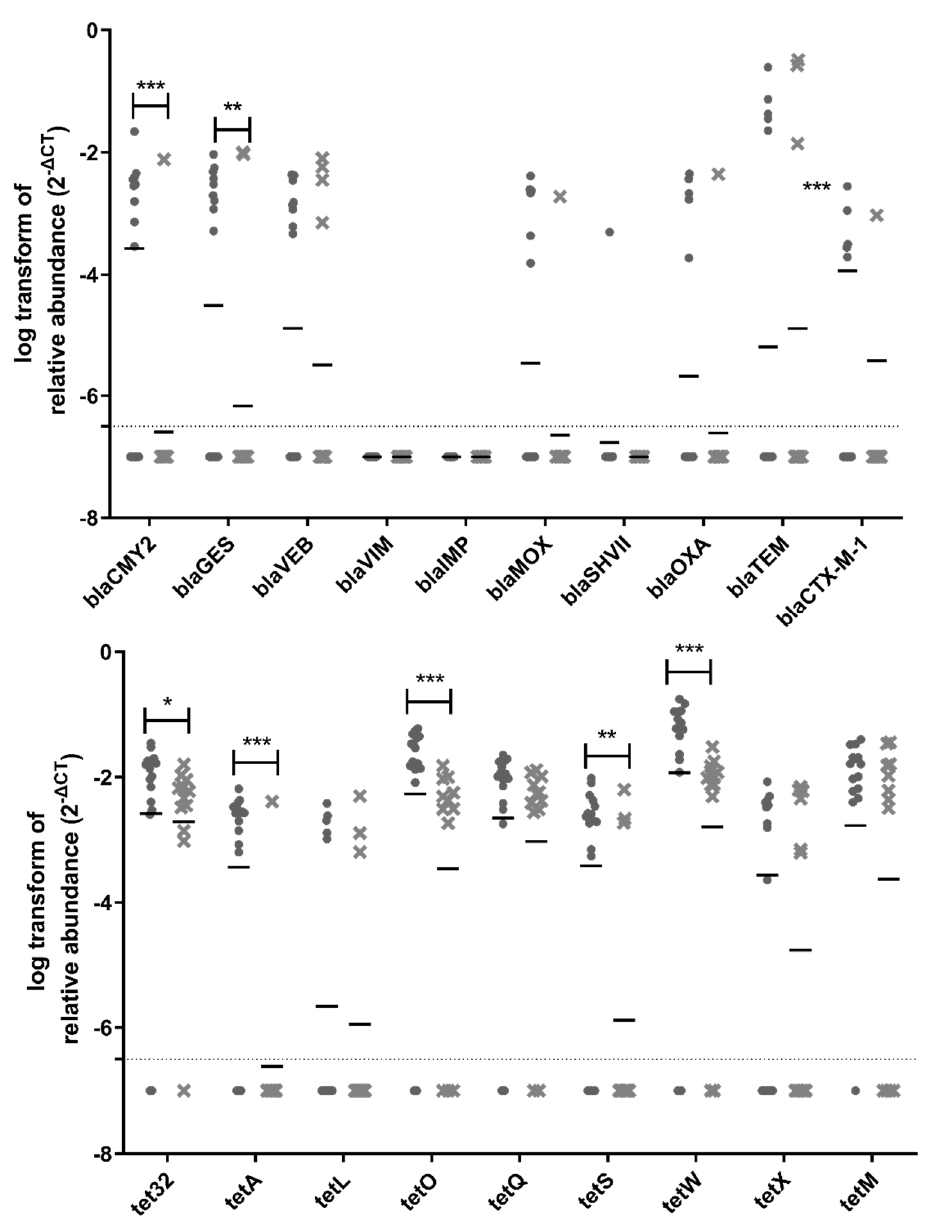
Figure 6. Relative abundance of ARGs in samples. The circles represent samples upstream of the biofilter, and the crosses represent samples downstream of the biofilter. The samples for all three sampling days are grouped in these graphs. The median is shown as a horizontal line for each set of data. The dotted line represents the quantification limit. A non-parametric mixed statistical model was performed to assess whether the change between upstream and downstream samples was significant for each ARG. Significant differences are indicated with stars (*: 0.01 < p -value < 0.05; **: 0.001 ≤ p -value < 0.01, ***: p -value < 0.001).